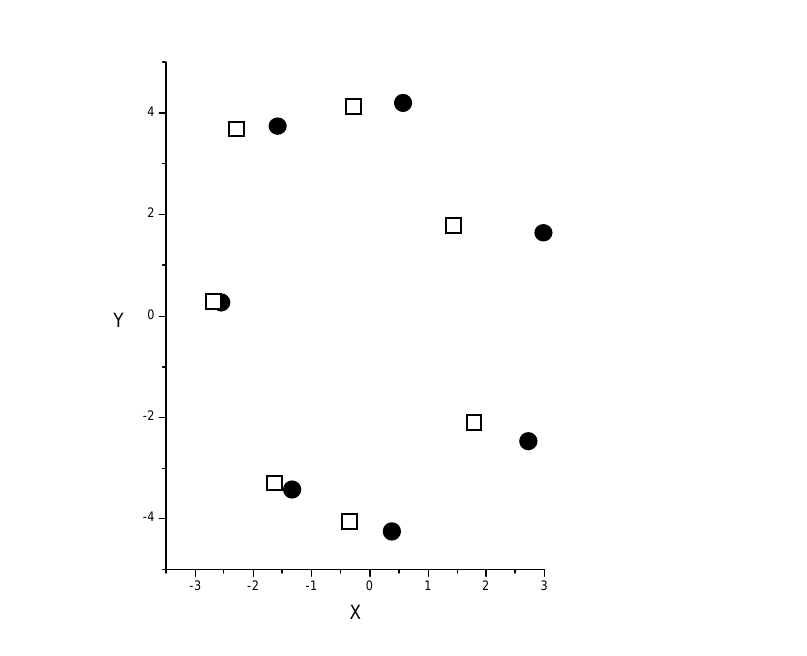
Figure 4. Projection of BCD and methoprene-BCD complex glycosidic oxygens